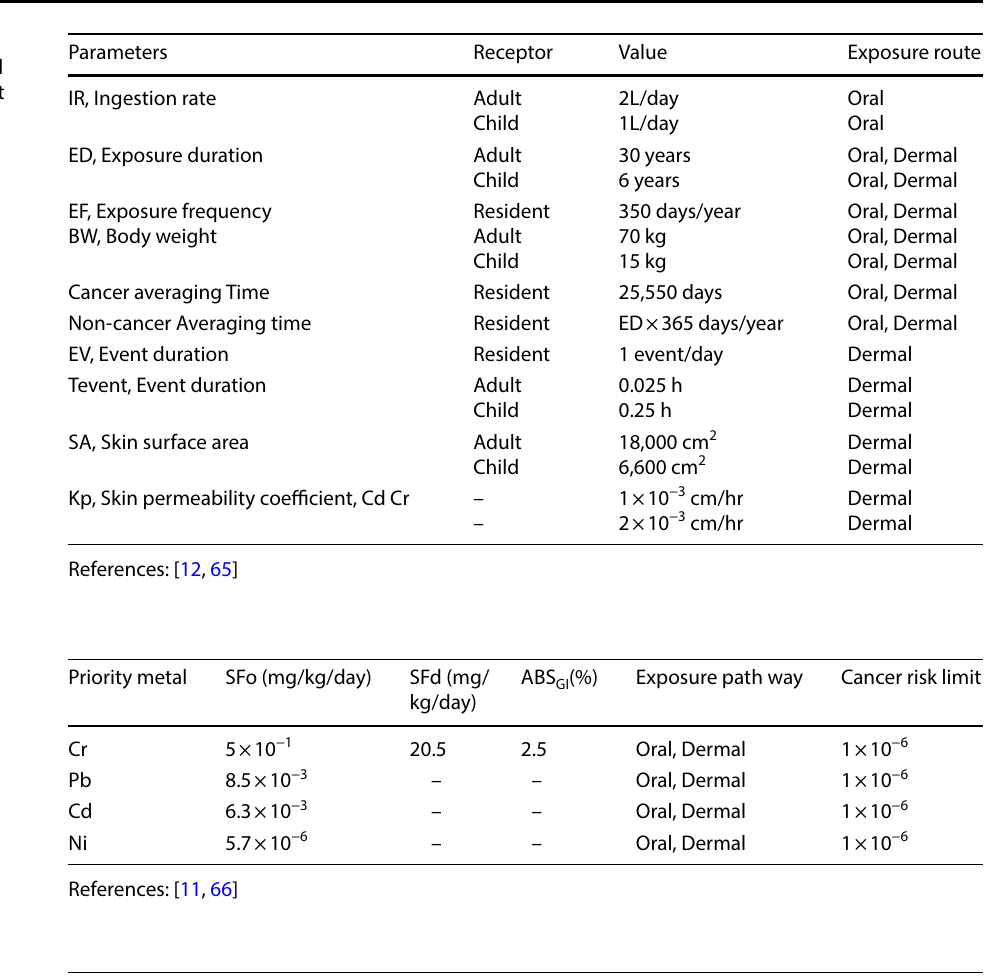
Table 6 Summary of non- cancer toxicity